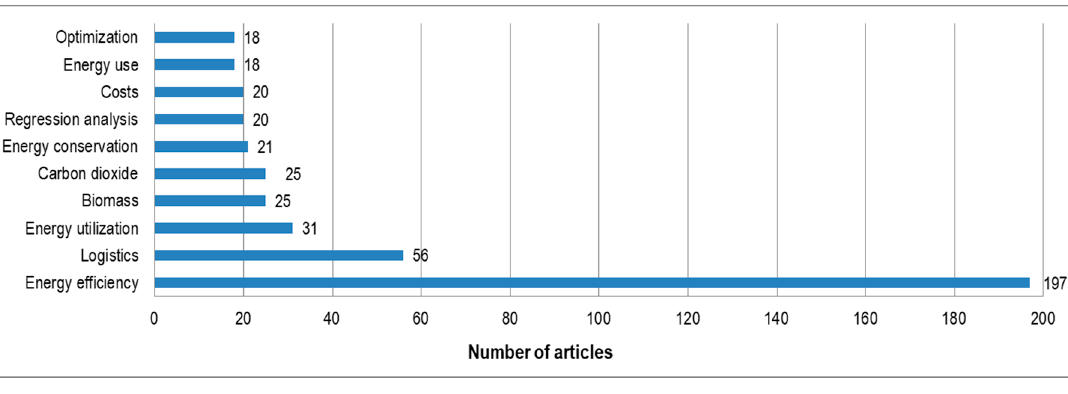
Figure 3. Classification of articles considering the used keywords.